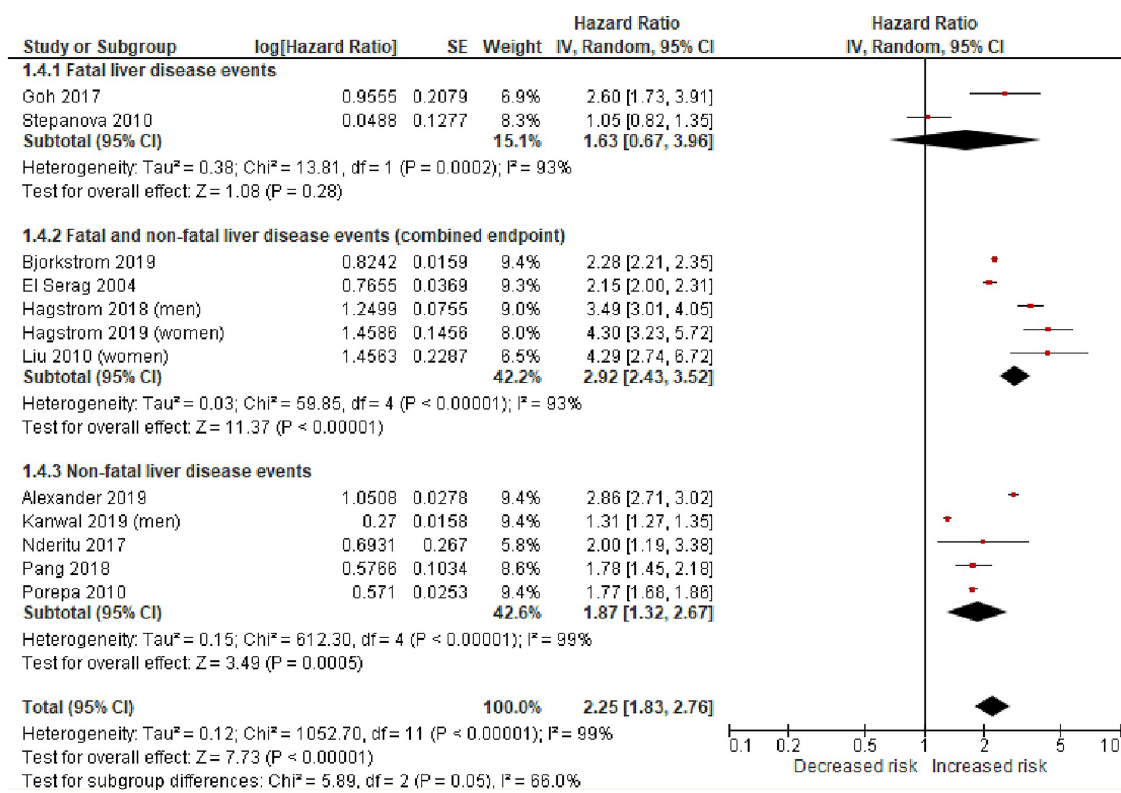
Fig 2. Random-effects meta-analysis of the risk of incident severe liver disease associated with type 2 diabetes. Statistical test for study heterogeneity = chi-squared test. Statistical test for summary effect in the meta-analysis = Z test. IV, inverse variance.